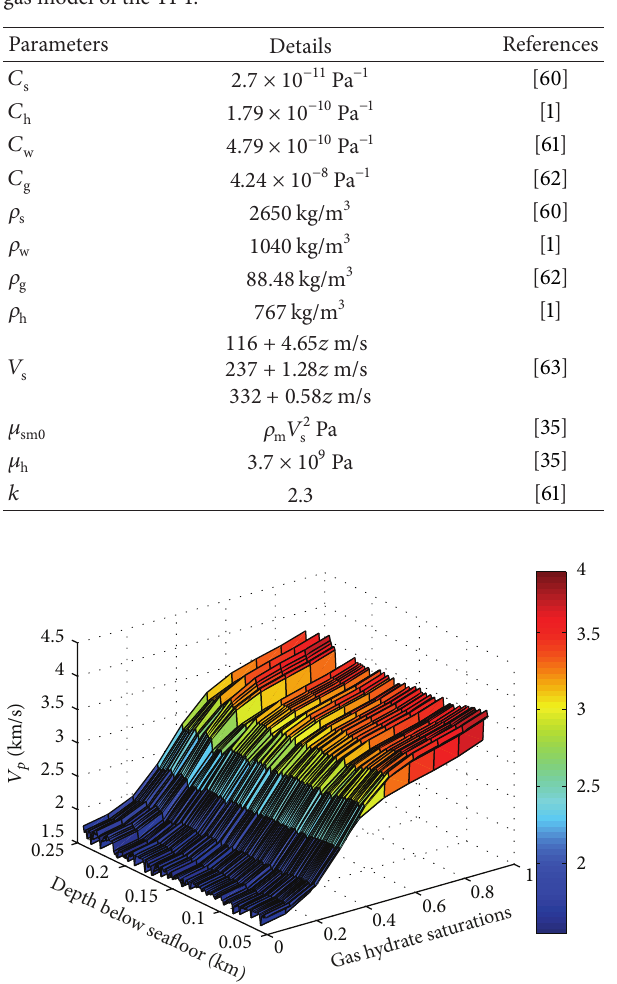
Figure 5: Relation between P wave velocity and sediment porosity, gas hydrate saturation at site SH2. (Because of the effect of variation of borehole conditions and actual sediments, the sediment porosity in some intervals does not reduce with the increasing depth and causes the curved surface unsmooth growth. In depth of 195 to 220 mbsf of gas hydrate reservoir, P wave velocity surface of forward simulation subsides as the sediment porosity relatively increases.)